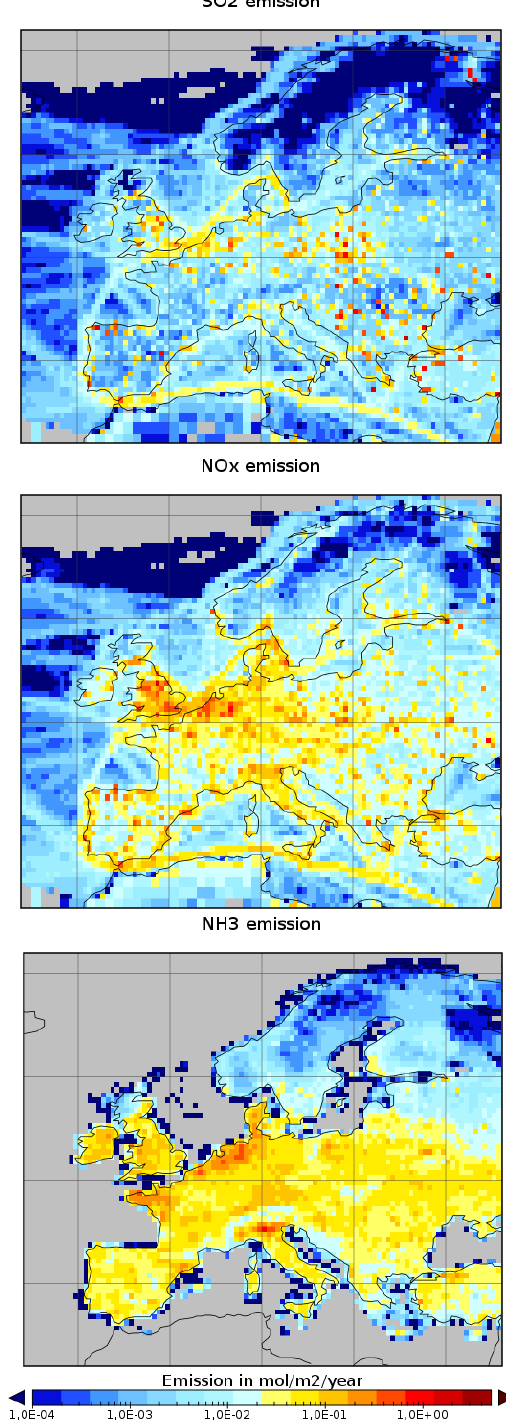
Figure 9. Maps of annual emissions for sulfur dioxide (top panel), nitrous oxides (middle panel) and ammonia (bottom panel) in molm − 2 year − 1 for the MOCAGE simulations (RACM and